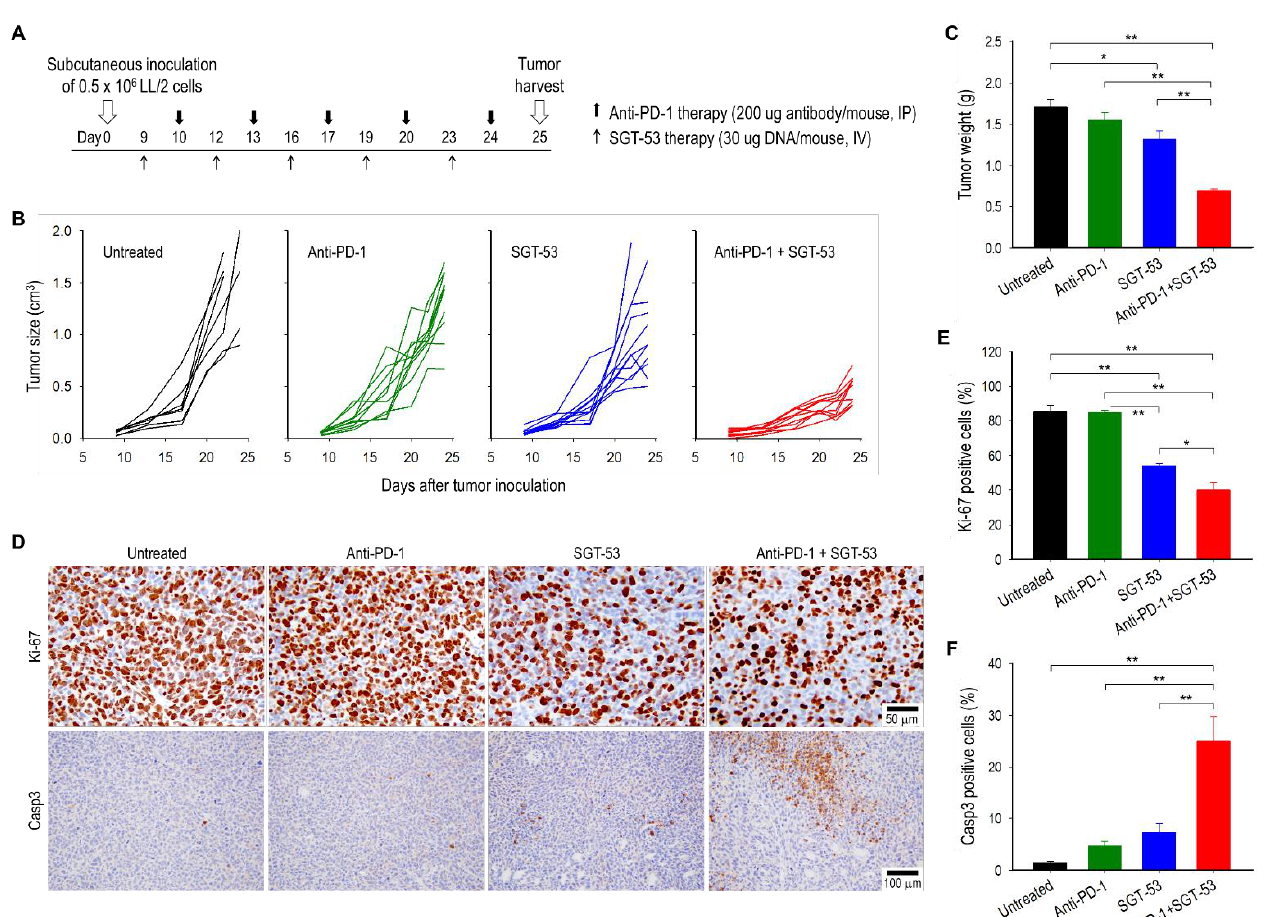
Figure 1. Combination treatment of anti-PD-1 and SGT-53 inhibits NSCLC growth. C57BL/6 mice with subcutaneous LL/2 tumors were randomized to therapy with anti-PD-1 (200 µg, IP) only, SGT-53 (30 µg DNA, IV) only, or the combination of both agents. ( A ) Treatment schedule. ( B ) Changes in individual tumor sizes. ( C ) Tumor weight at harvest on day 25. ( D ) IHC examination of tumors. Representative staining of Ki-67 and Casp3 are shown. Quantifications of positive stain of ( E ) Ki-67 and ( F ) Casp3. Data are presented as mean ± SEM and were analyzed by one-way ANOVA. * p < 0.05, ** p < 0.001. n = 7 – 10/group.